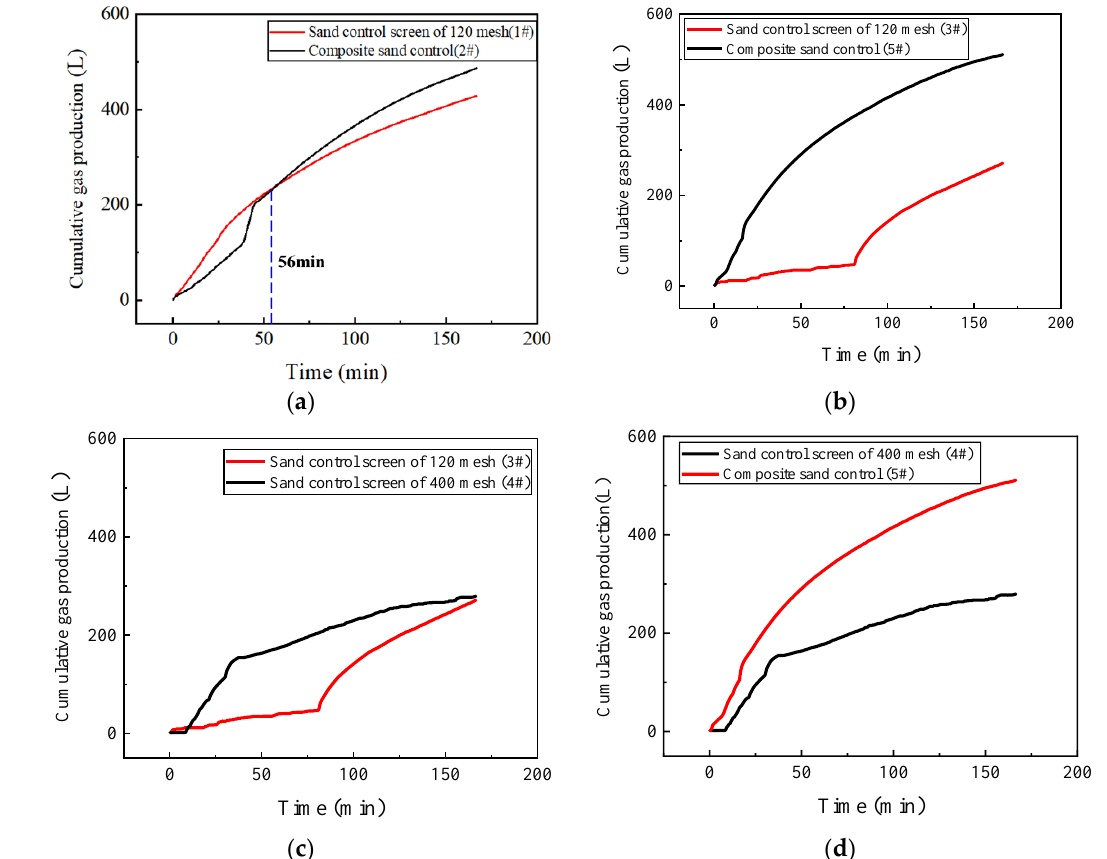
Figure 13. ( a ) Comparison of cumulative gas production of different sand control methods in vertical wells; ( b – d ) Comparison of cumulative gas production of different sand control methods in radial well.